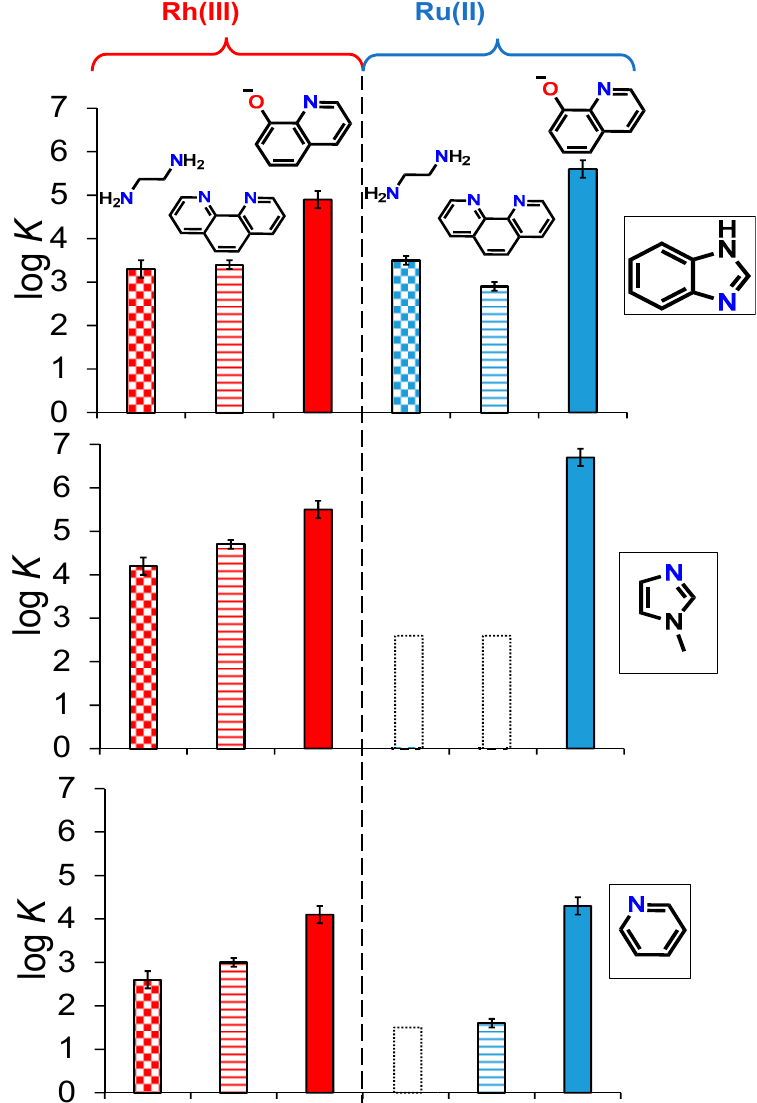
Figure 5. Formation constants (log K ) determined for mixed‑ligand half‑sandwich complexes of Rh(III) and Ru(II) by UV‑vis and 1 H NMR spectroscopy. Empty bars with a dotted line indicate maximum values, which could not be determined under the given conditions. Values are collected ◦ in Table S2. { I = 0.10 M (KCl); t = 25.0